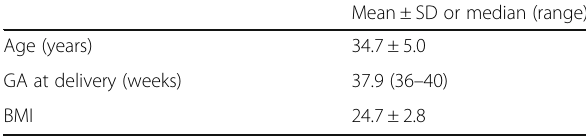
Table 1 Maternal demographic and clinical